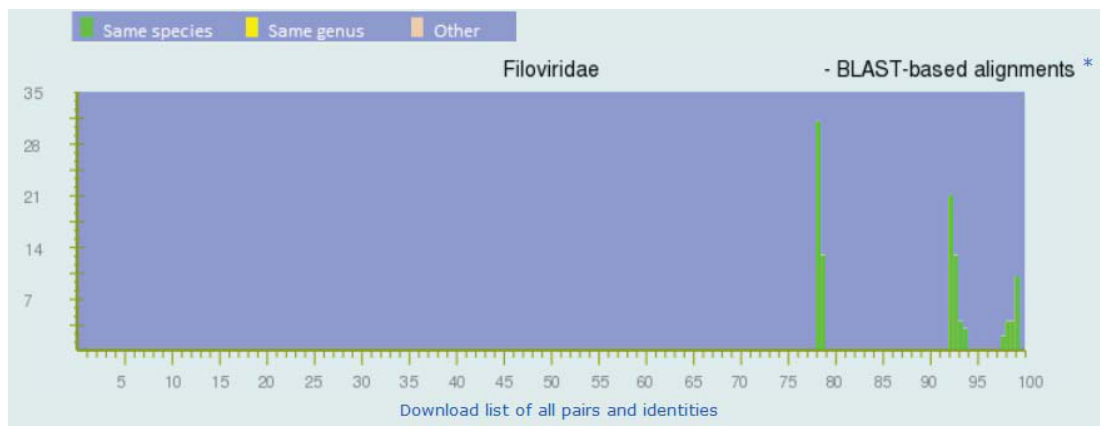
Figure 3. Frequency distribution of pairwise identities from the complete genome sequences of marburgviruses. The three peaks from right to left represent the pairs of viruses within each of the five major lineages of marburgviruses, between the four lineages of Marburg virus (MARV), and between Ravn virus (RAVV) and MARV.